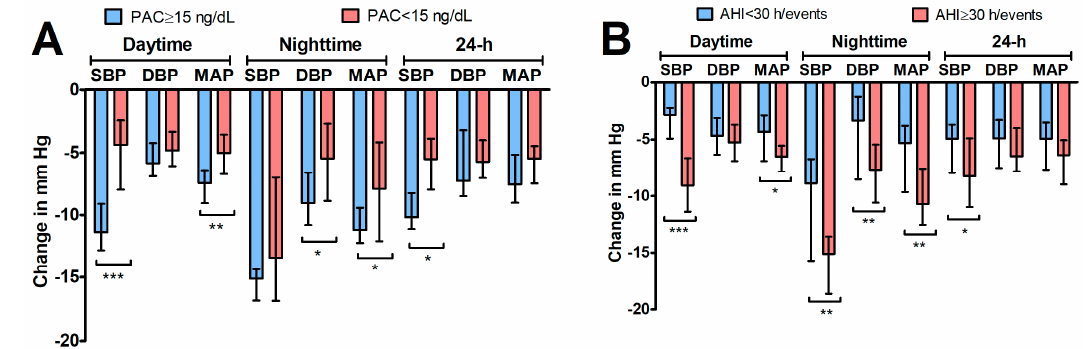
Figure 3. Changes in BP parameters (median and interquartile range) in patients receiving eplerenone for 6 weeks ( n = 51) in relation to their baseline aldosteronism ( A ) and apnea–hypopnea index (AHI) ( B )status. Asterisks indicate significant differences (* p < 0.05; ** p < 0.01; *** p < 0.001; Mann–Whitney U test).